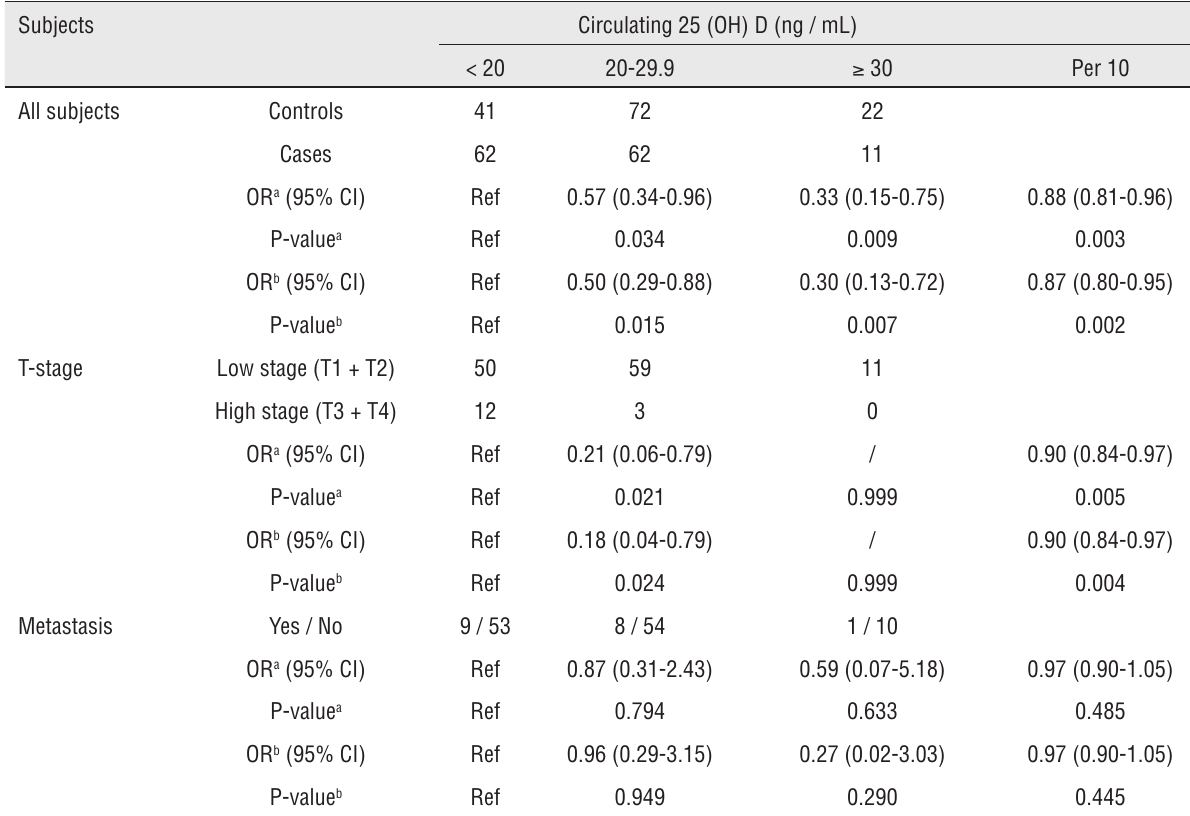
Table 3 - Association between 25 (OH) D and the risk of renal cell carcinoma in total, and according to tumor stage and